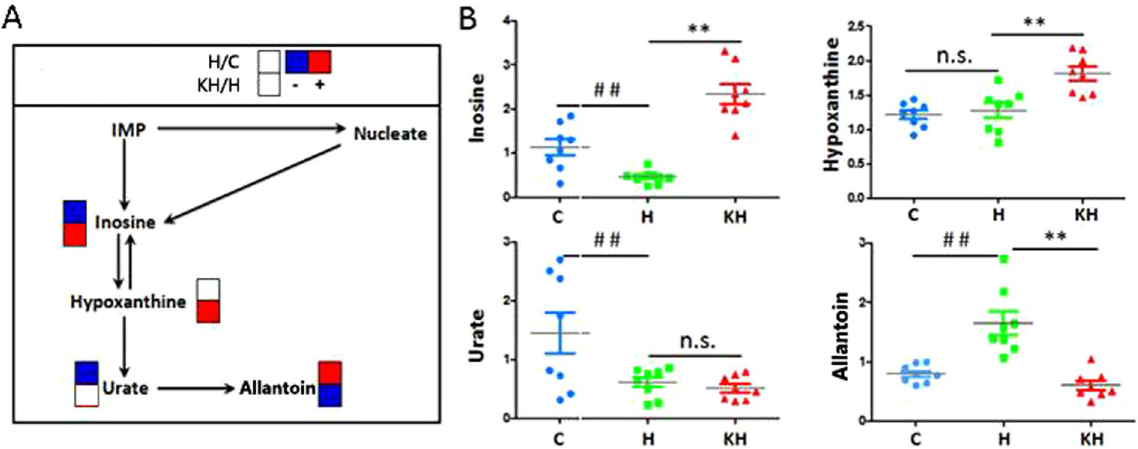
Figure 8. ( A ) The changed purine metabolic pathways in response to heat exposure after Kisspeptin intervention; ( B ) Normalized mean peak areas of metabolites in rats intervened with Kisspeptin compared with the heat stress group.(n = 8). In the figure A, the red square denotes an elevated concentration of metabolites present in the liver tissue, whereas blue square means a reduced level of metabolites. IMP,Inosine 5-monophosphate; Urate,Uric acid. ## Indicates p < 0.01 compared to the C group; ** Indicates p < 0.01 compared to the H group. C: Control group; H: Heat stress group; KH group: Kisspeptin + Heat stress